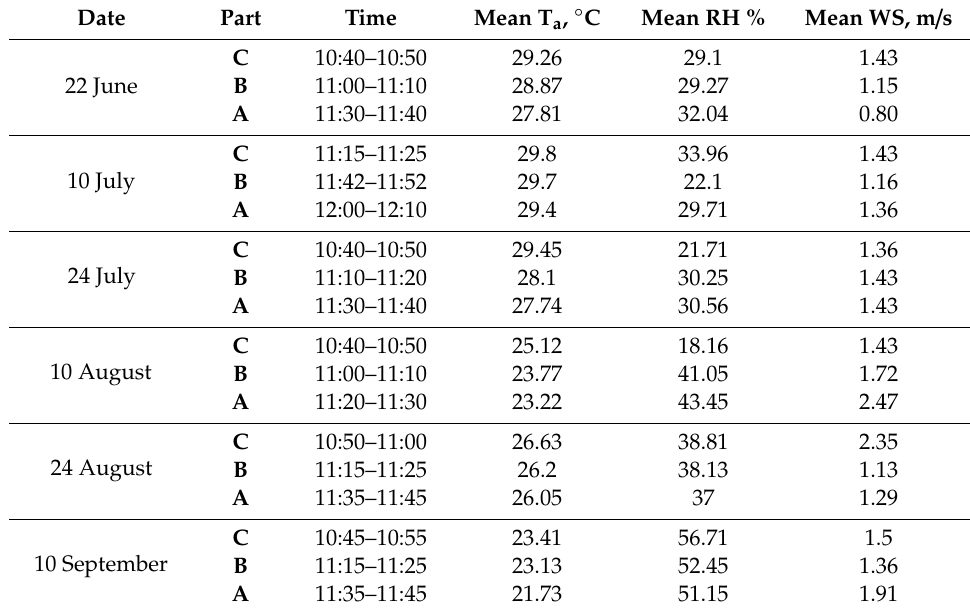
Table 2. Intersection mean values for air temperature (T a ), relative humidity (RH) and wind speed (WS) on all measurement days (10:40–12:10